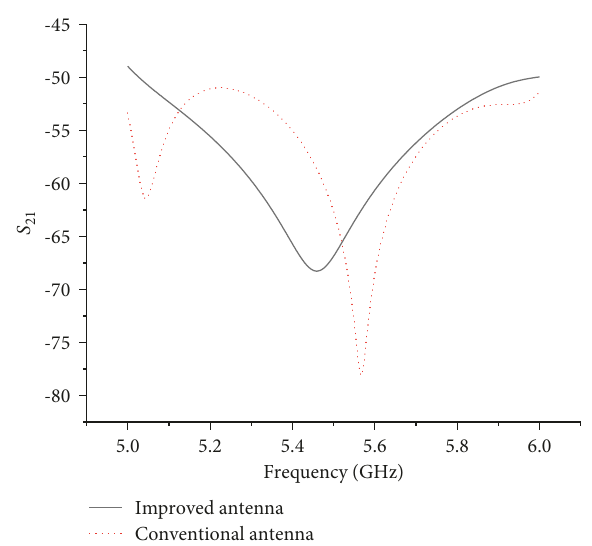
Figure 16: Performance comparison between conventional and improved